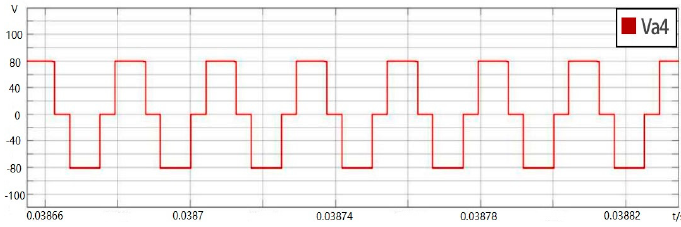
Figure 16. Voltage waveform of low voltage side of transformer.